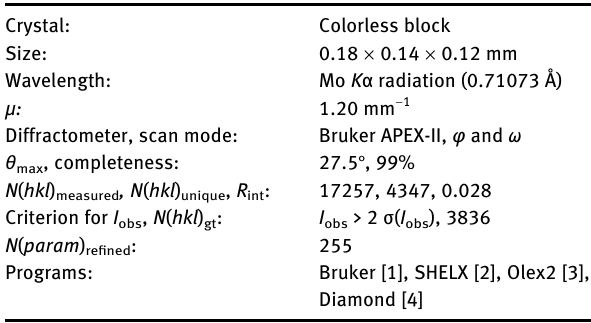
Table 1 contains crystallographic data and Table 2 contains the list of the atoms including atomic coordinates and displacement parameters.